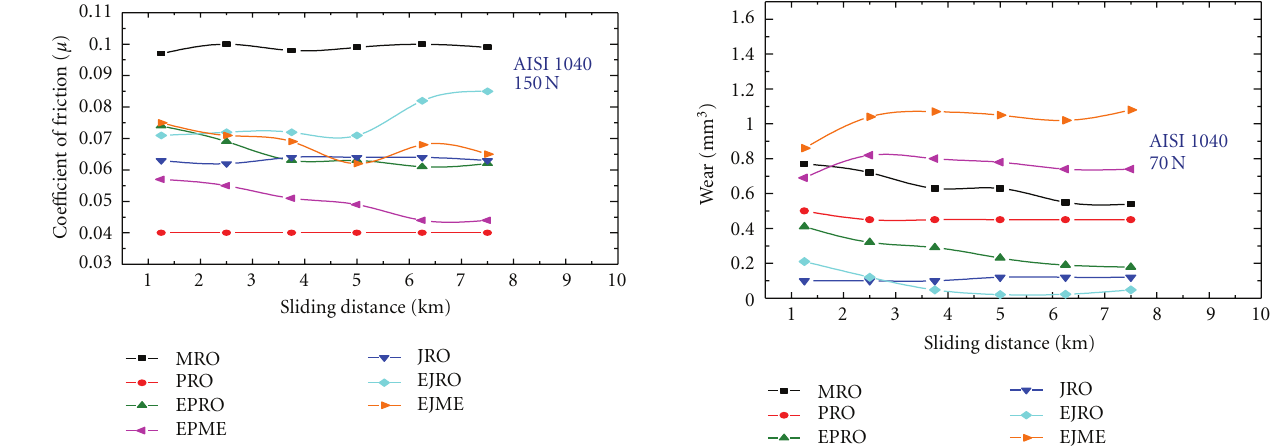
Figure 3: Variation of coe ffi cient of friction with sliding distance for 150 N.